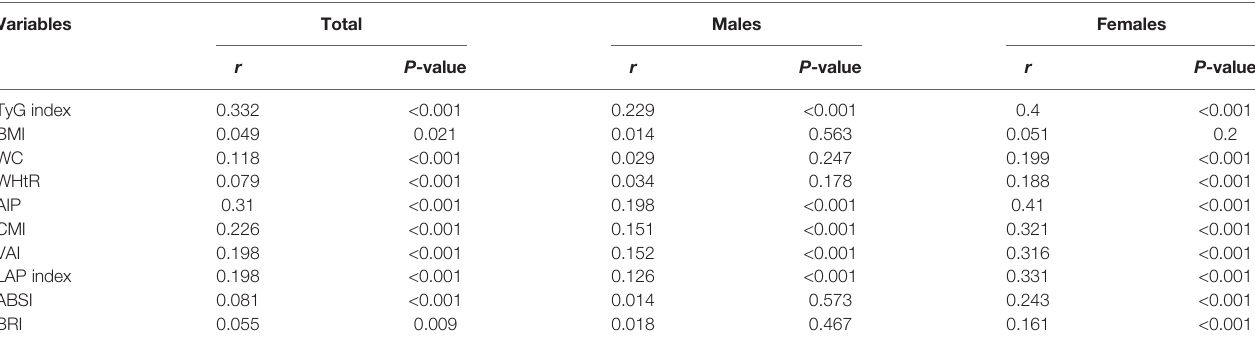
TABLE 2 | Partial correlation coef fi cients between different indices and SUA. Variables